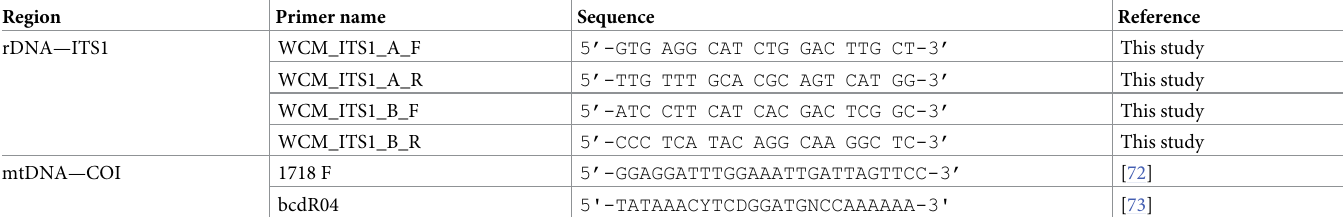
Table 3. Primers used to amplify nuclear ribosomal internal transcribed spacer one (ITS1) and cytochrome oxidase I (COI) in A . tosichella biotype 1 and 2.